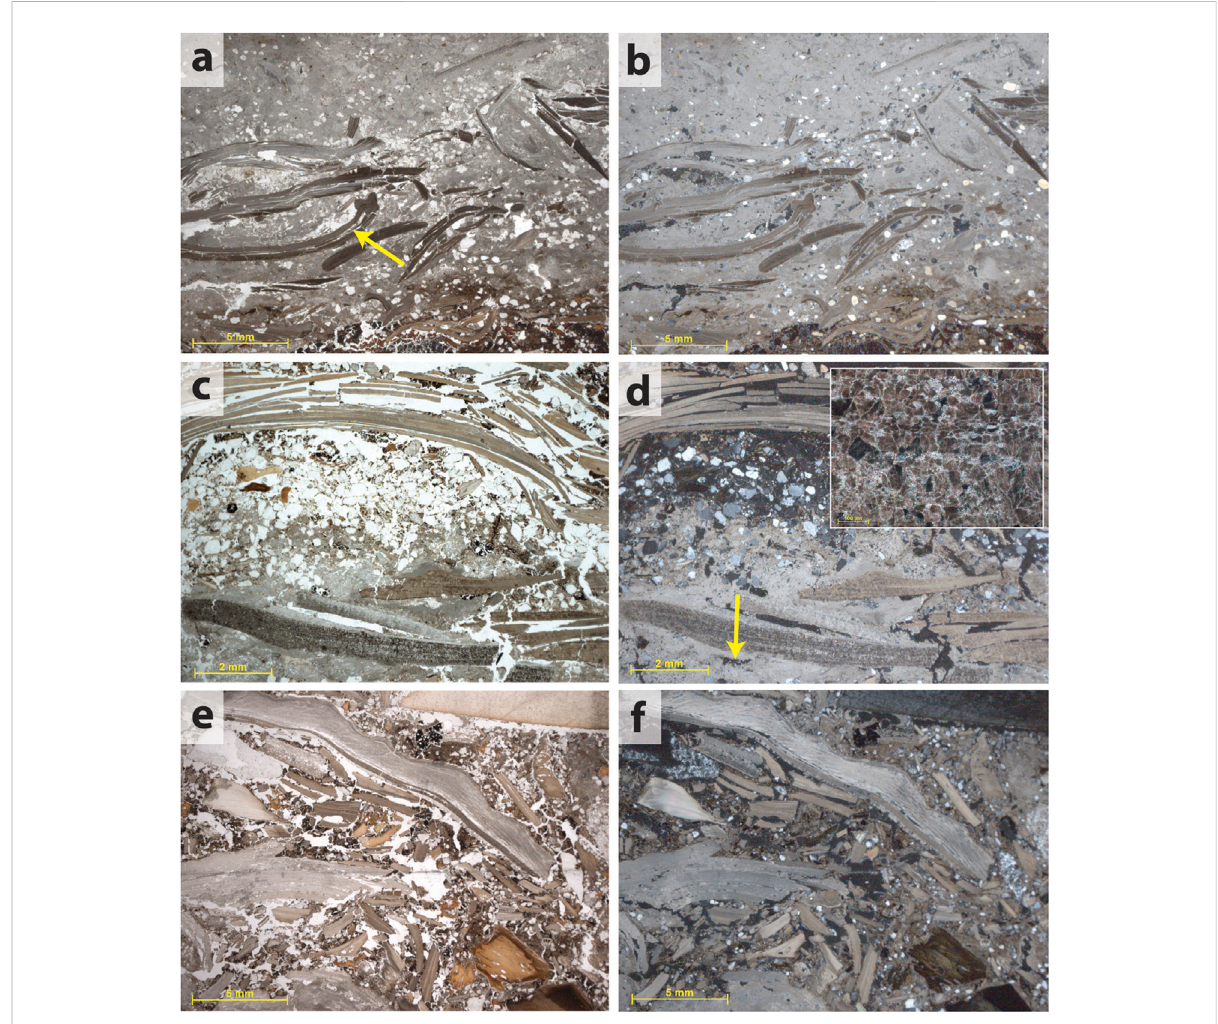
FIGURE 5 Impacts of human activities on the preservation of shell. (A) Burned shells in a hearth, sample KRM-13-07 from the LBS of Cave 1. According to theresultsofthe μ FTIRanalyses,alloftheshellsinthisheartharenowcomposedofcalciteduetoheating[seealsoLarbeyetal.(2019)].Burnedshells are also darker in PPL, ranging from medium to dark grey in color. Here, some shells exhibit delamination. The arrow indicates a fi ssure void formed within a bivalve shell from delamination between the inner nacreous and outer prismatic layers that extends to the hinge plate. PPL. (B) Same view as (A) , XPL. The fi ne matrix surrounding the shells is ash, while a small portion of the basal charred layer of the hearth is visible in the lower left corner. (C) The lower part ofthe imageshows shells embedded inthe ash layerof ahearth located several cm below theprevious images. The shells are both heated and recrystallized. A similar change in orientation of calcite crystals has been reported in heated shell by Villagran et al. (2011b). The upperpartoftheimageshowsshellsthatarefragmentedinplaceduetocompression,possiblyrelatedtotrampling(c.f.Villagranetal.,2011a). μ FTIR analyses indicate that all of the recrystallized shells within the hearth are composed of calcite, while the upper fragmented shell is composed of aragonite. PPL. (D) Same view as (C) , XPL. Arrow indicates a small zone of phosphatized ashes, con fi rmed as hydroxyapatite with μ FTIR. The inset image shows the recrystallization of one of the shell fragments at high magni fi cation, also XPL. (E) This image from KRM-13-06a (also in the LBS) shows the impact of fragmentation due to trampling followed by local reworking of shell with other wastes, including fragments of bone, ash and charcoal. μ FTIR analyses indicate that the bone fragments visible in this image were burned at a range of intensities. PPL. (F) Same view as (E) ,